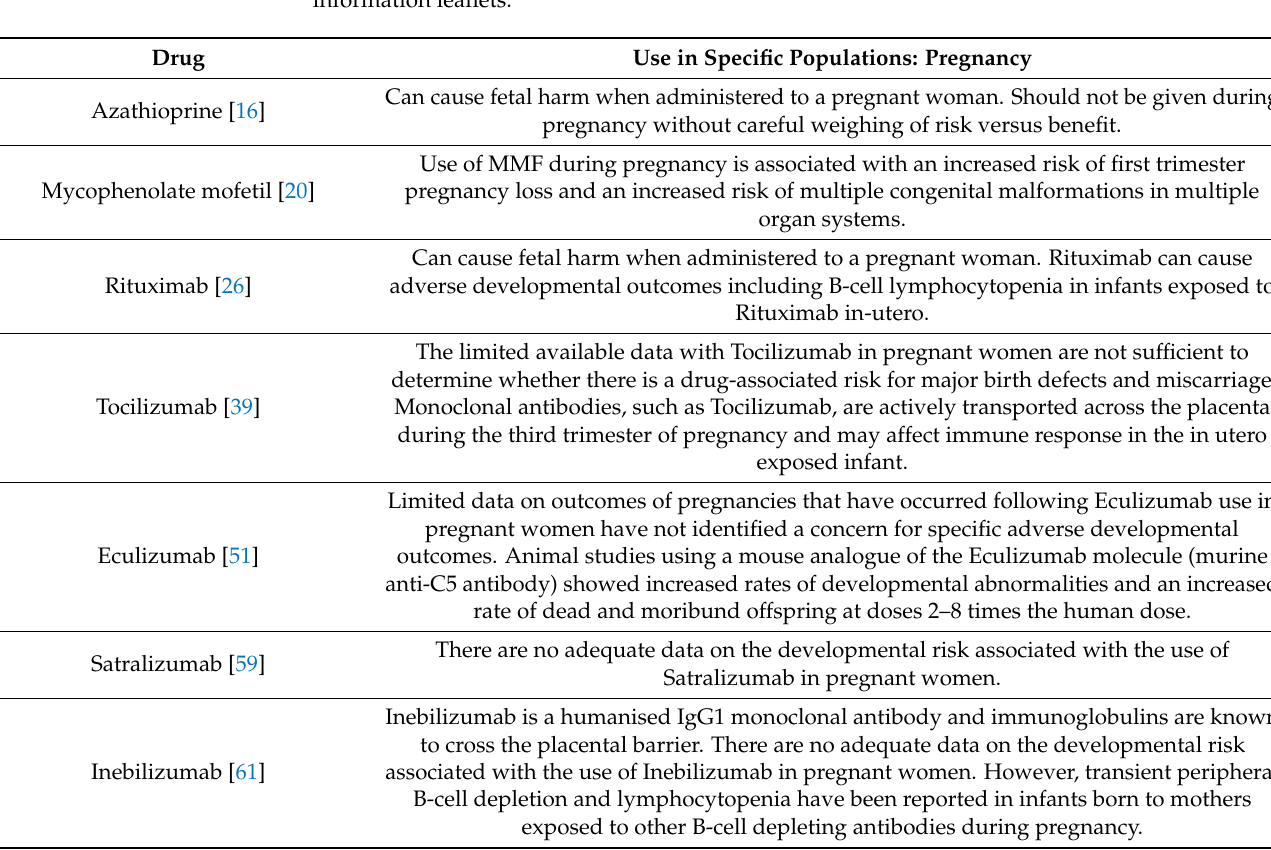
Table 2. Advice on the use of drugs in pregnancy, quoted from the FDA-approved prescribing information